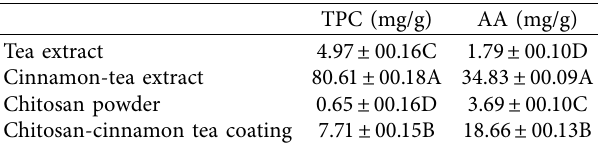
Table 1: Total phenol content and antioxidant activity of coating materials.